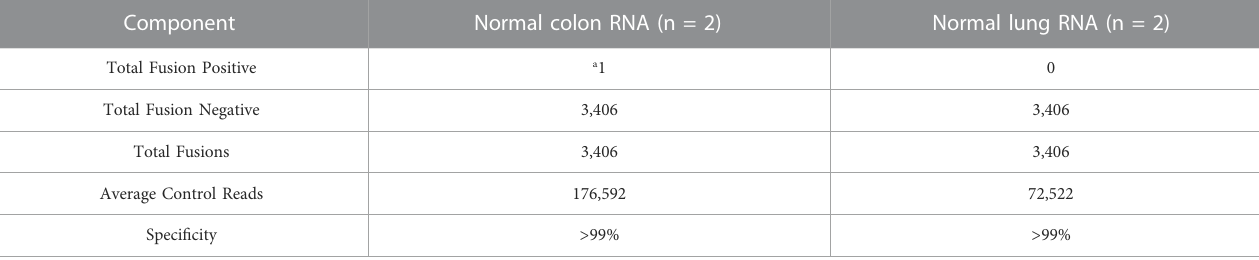
TABLE 13 Speci fi city. Analytical speci fi city of RNA